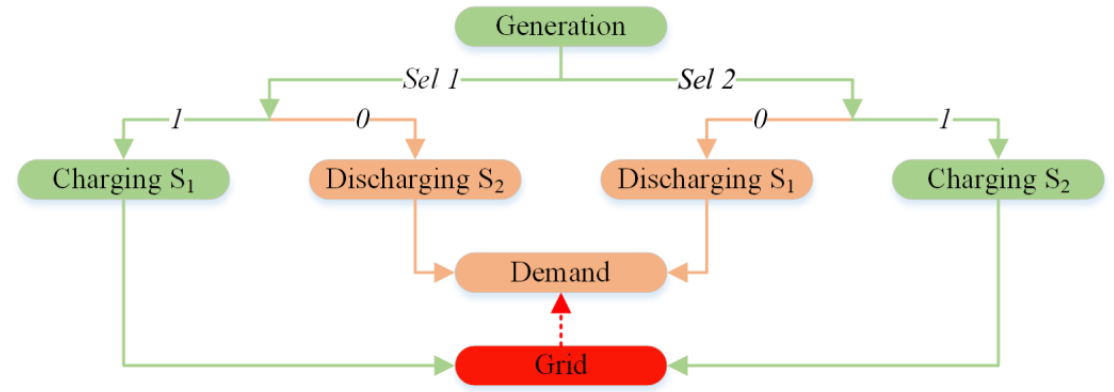
Figure 2. Schematic of charging and discharging for two energy centres, S 1 and S 2 . Overall, despite the increase in capital cost, the overall cost